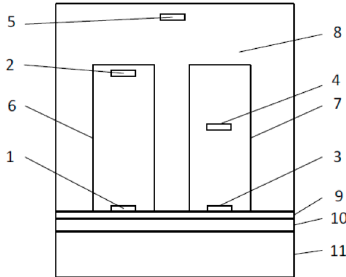
Figure 1. Transducer structure: 1, 2, 3, 4, and 5—temperature sensors (Thermistor 5 can be used to inspect the thermo-isolation cover); 6—thermal channel; 7—thermal channel; 8—thermo-insulation cover; 9—skin; 10—fat; and 11—muscle.